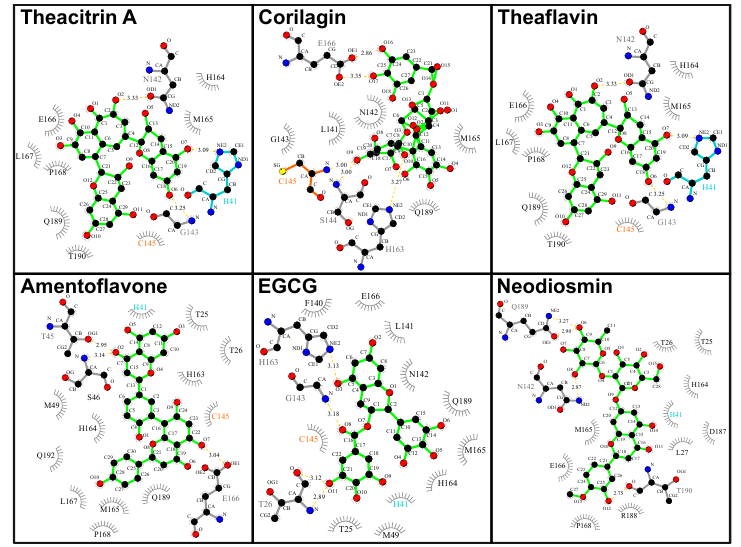
Figure 8. The 3CL pro –compound interactions for the six best natural drugs. The interactions were analyzed and plotted with LigPlot+ [36,37]. Hydrogen bonds are indicated by orange dashed lines between the atoms involved and the donor–acceptor distance is given in Å, while hydrophobic contacts are represented by gray arcs with spokes radiating towards the ligand atoms they contact. The contacted atoms are shown with spokes radiating